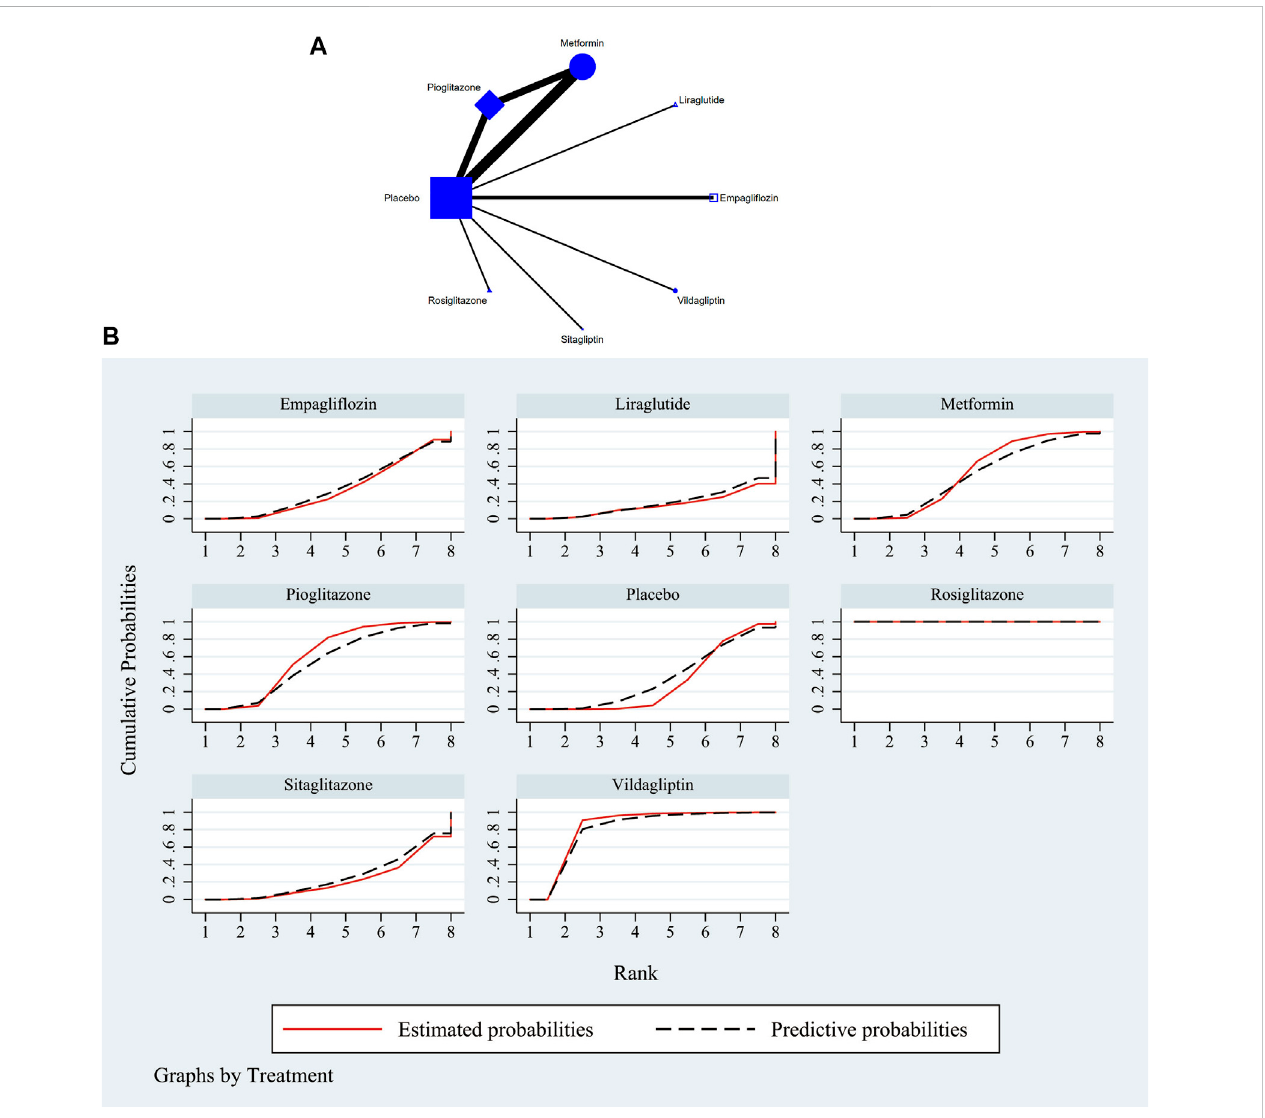
FIGURE 2 (A) NMA fi gure for ALT. Each node stands for a different treatment. The size of each node is based on how many people were given that treatment. The lines show direct comparisons, and the width of the line depends on how many trials were done. (B) SUCRA plot for ALT. The cumulative rank likelihood of each therapy is represented by the area under the curve, with bigger areas denoting higher